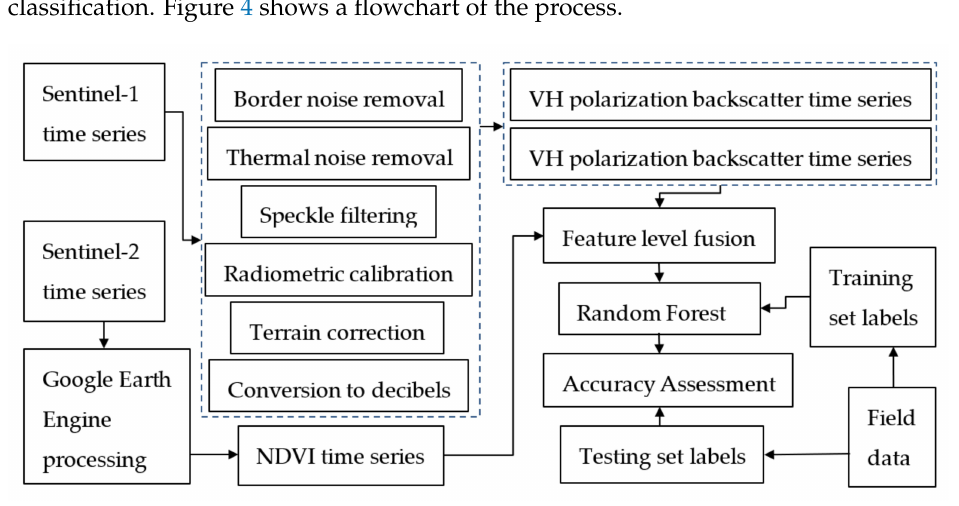
Figure 4. Flow chart for of crop